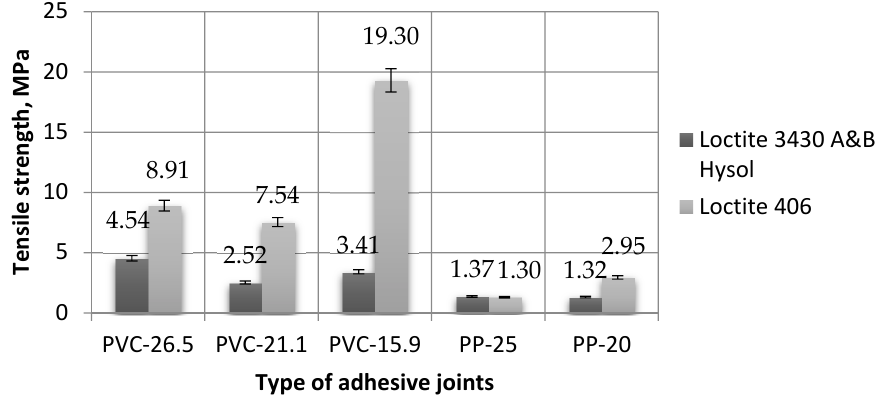
Figure 7. Tensile strength of butt-adhesive joints samples made with Loctite 3430 A&B Hysol adhesive and Loctite 406 adhesive.